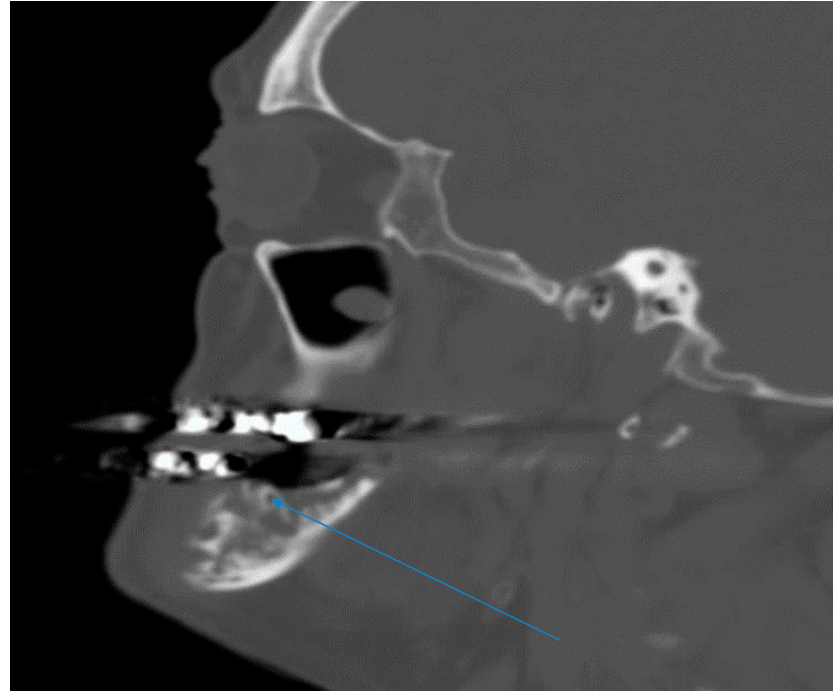
Figure 2. Maxillofacial computerized tomography imaging showing a lytic lesion in left ramus of the mandible with loss of bone matrix (see arrow). Diseases 2018 , 6 , x